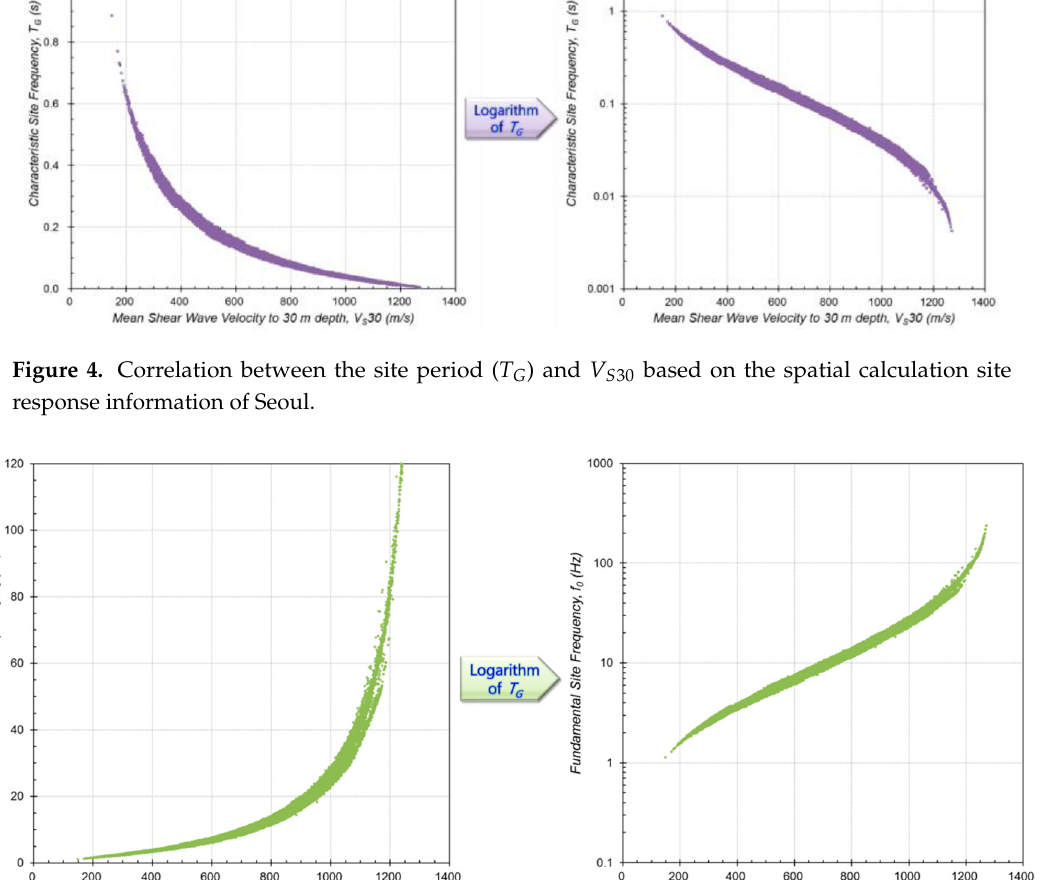
Figure 5. Correlation between the fundamental frequency ( f 0 ) and V S 30 based on the spatial calculation site response information of Seoul.